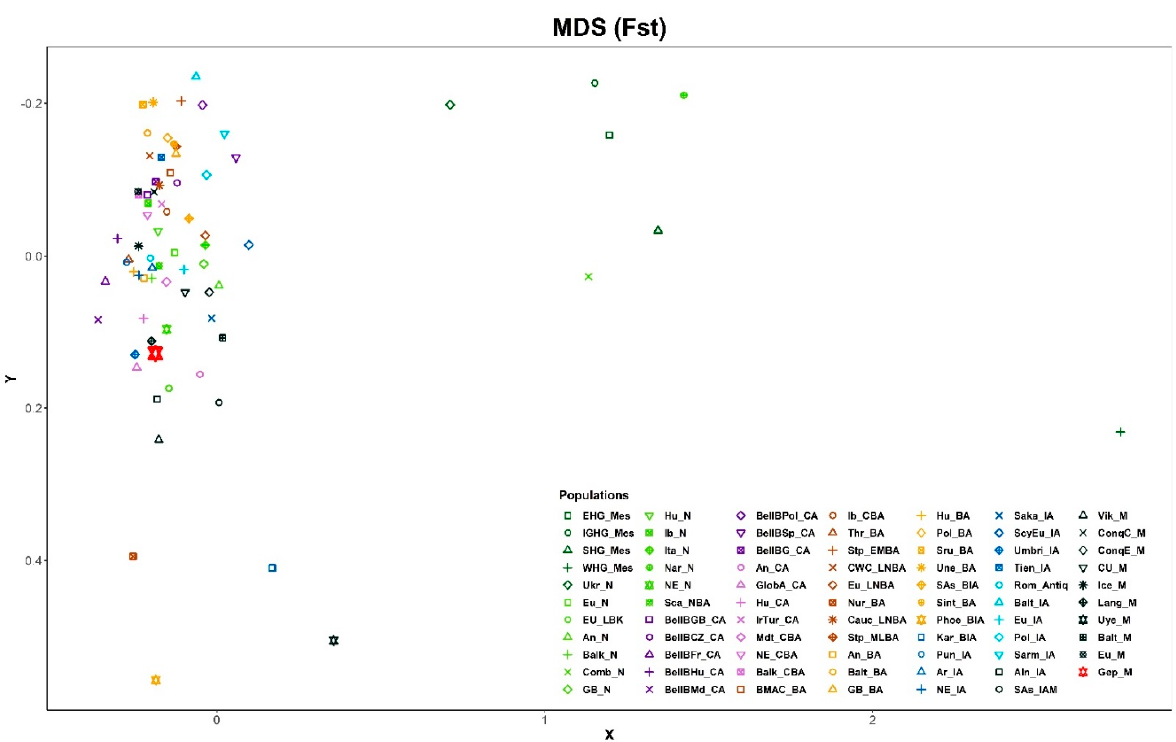
Figure 3. The principal component analysis (PCA) drawn from the major mtDNA haplogroup distributions of 93 Eurasian populations. The abbreviations of the population names are given in Table S4.